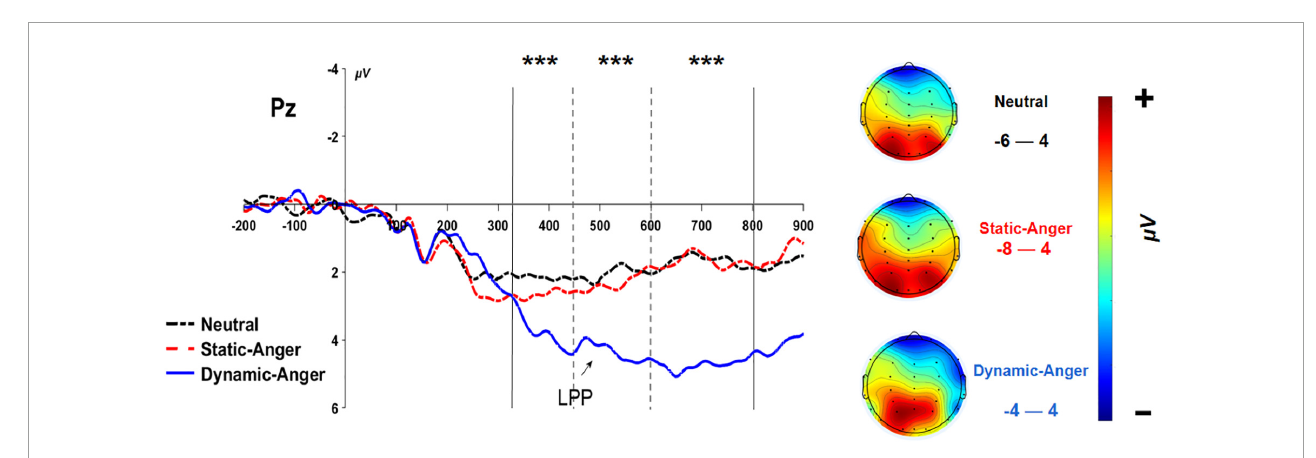
FIGURE6 The grand-mean ERP waveforms of the LPP component at Pz. *** P <